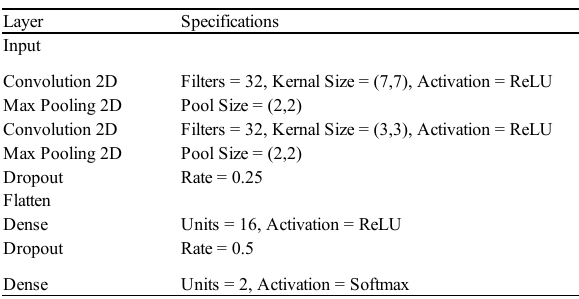
Table 3 . Structure of CNN.